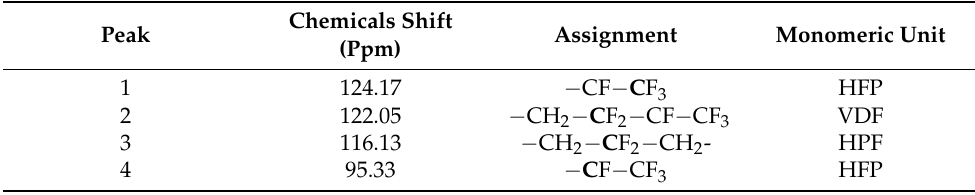
Table 2. Assignment of the chemical shift of 13 C{ 19 F} CP-MAS spectrum.